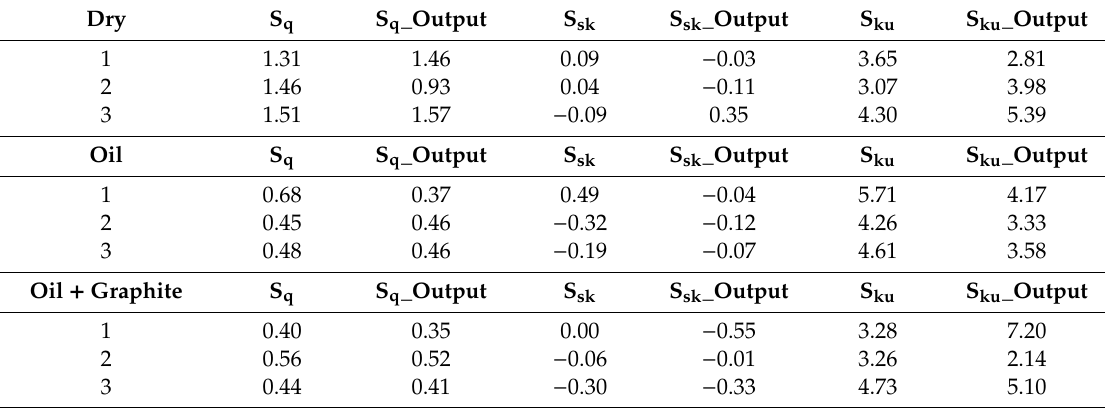
Table 14. Custom predictions—Superficial Roughness.